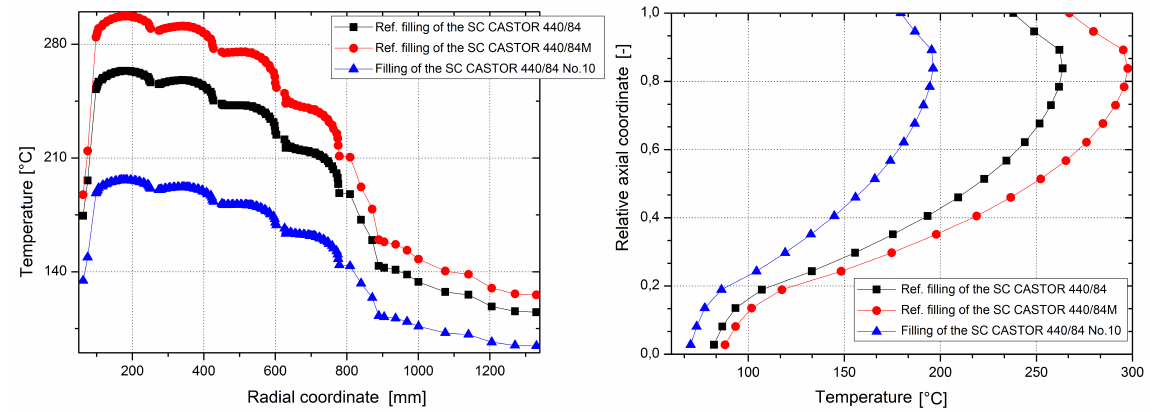
Figure 9. Radial (left) and axial (right) temperature distribution in SC CASTOR 440/84 for two reference cases and for the real SC No.10. In the case of filling the older CASTOR 440/84 with the licensed reference filling of the modified type CASTOR 440/84M, the PCT will reach almost 300 ◦ C which is more than 30 ◦ C di ff erence in the PCT in comparison with the CASTOR 440/84M.